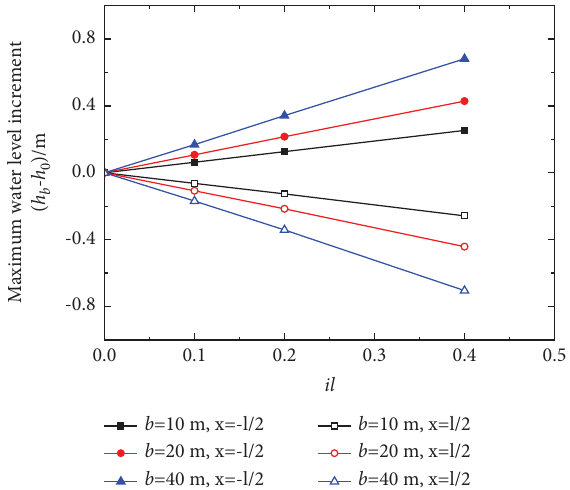
Figure 11: Variation in MWLI with the hydraulic gradient.